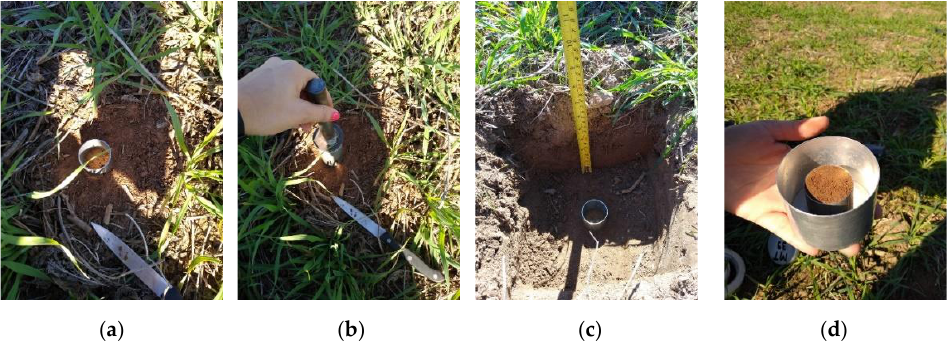
Figure 3. Collection of undisturbed soil samples at depths of 0 – 0.1 m ( a , b ), at a depth of 0.1 – 0.2 m ( c ), and field soil sample preparation procedure to be taken to the laboratory ( d ). Cachoeira do Sul, RS.